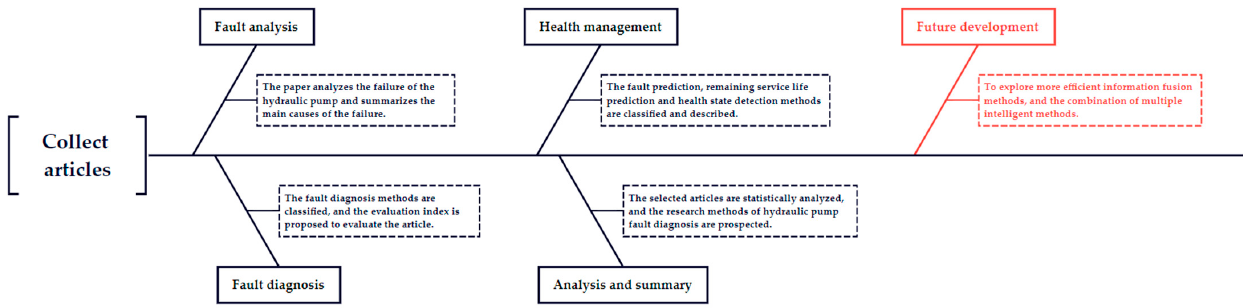
Figure 1. The research process of the